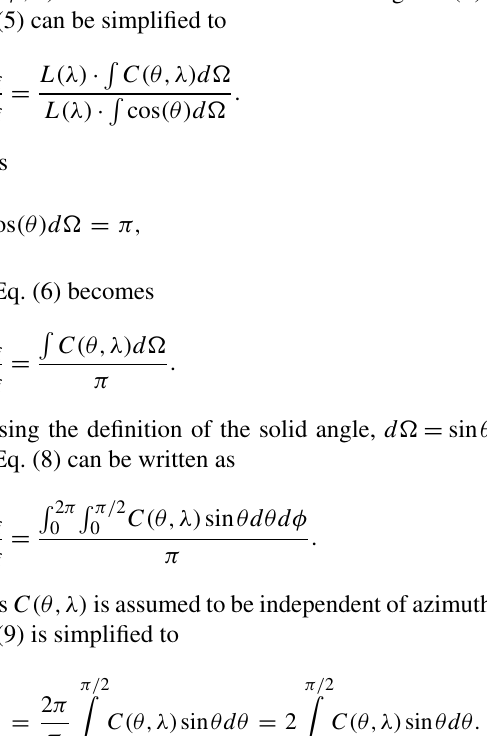
F (cid:48) diff Table 2. The ratios F diff for Brewers no. 037, no. 070, no. 107, no. 117, no. 151, no. 166 and no.